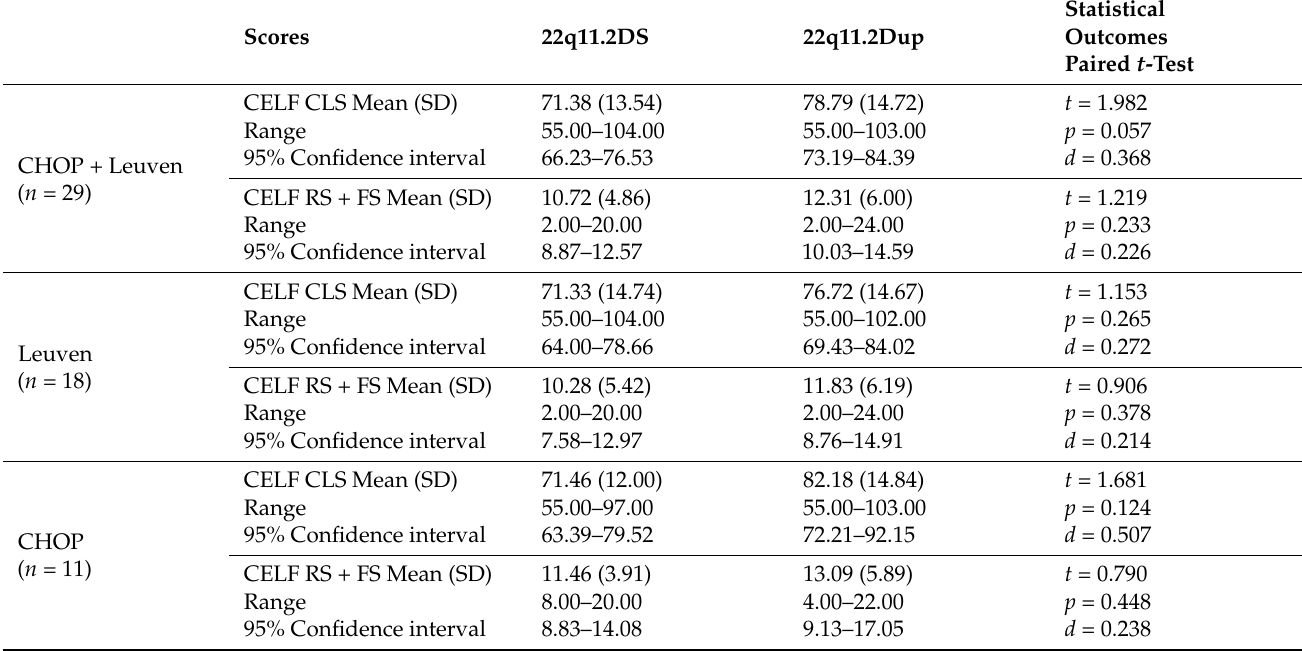
Table 3. Cross-CNV comparisons across CELF CLS and expressive composite scores.